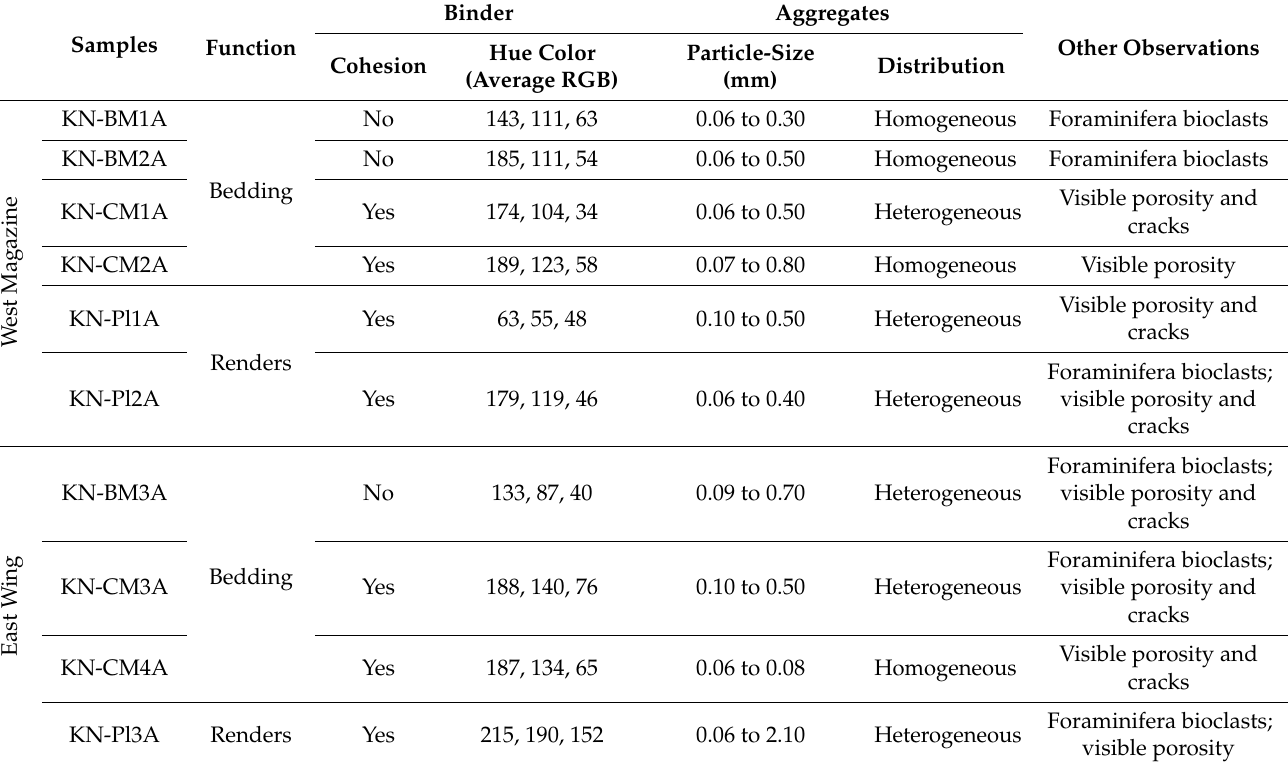
Table 2. Summary of the main characteristics of mortars observed by OM in cross